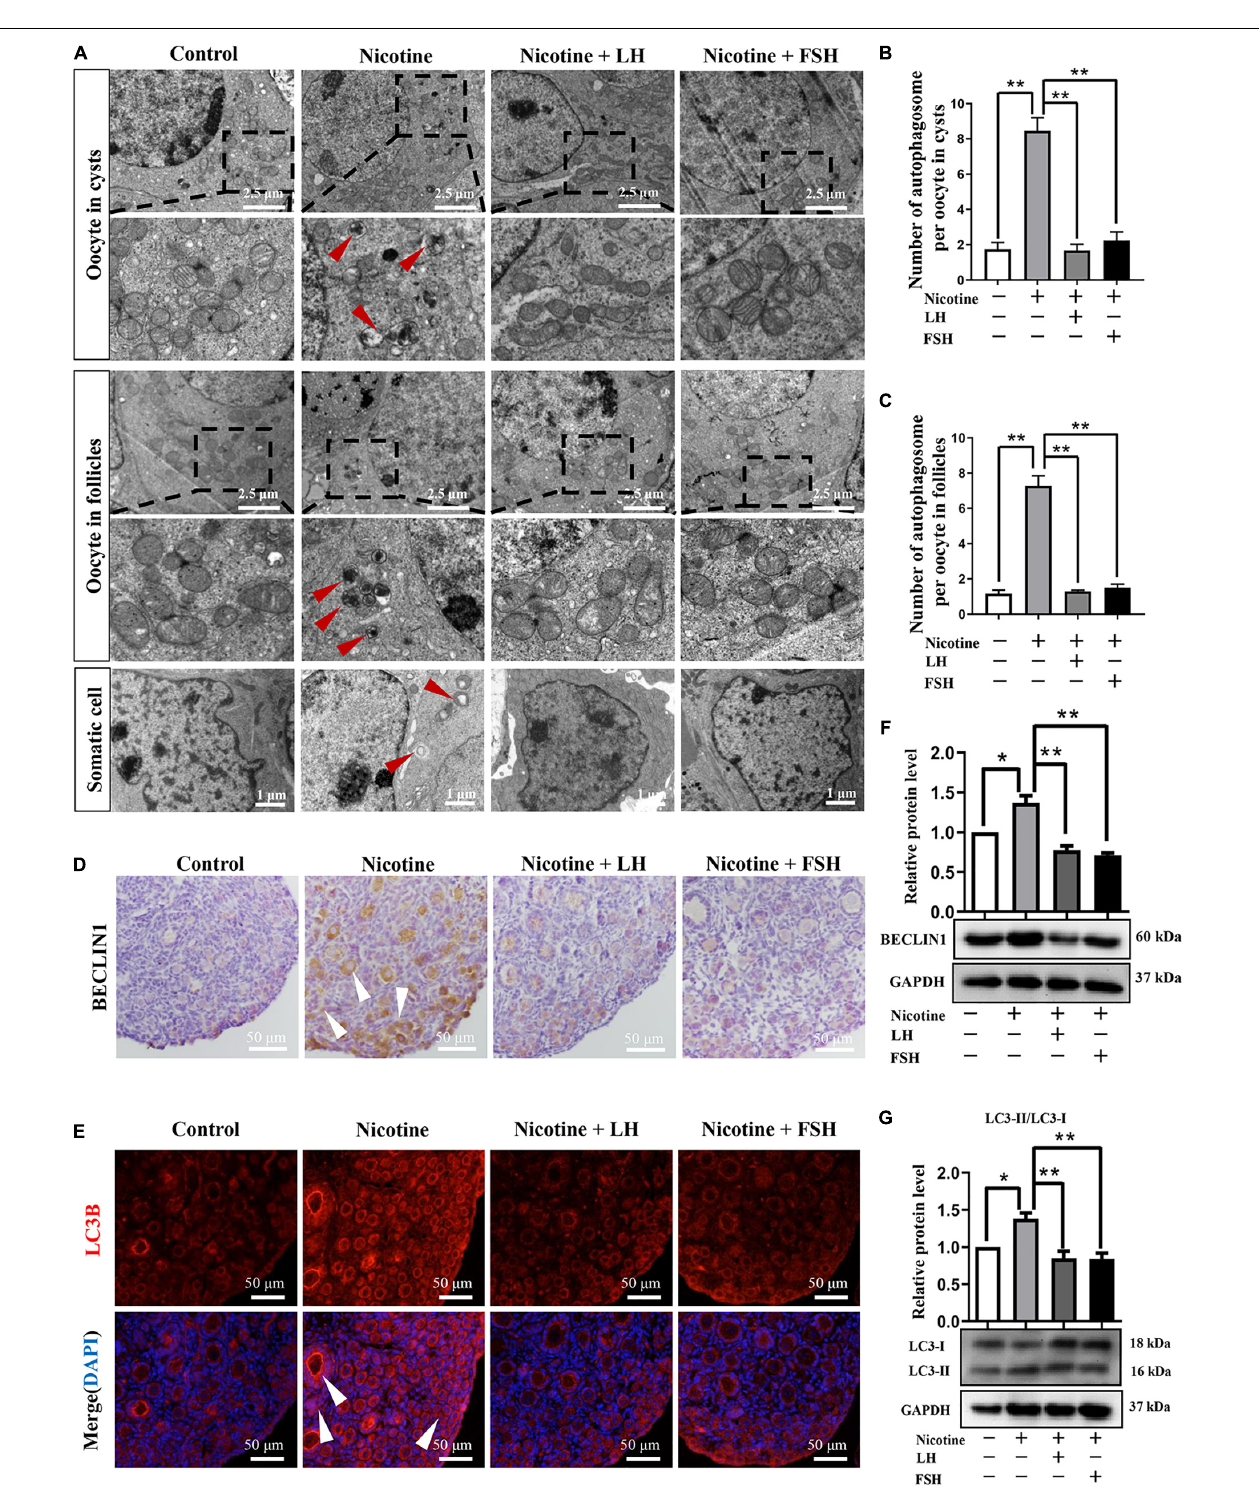
FIGURE 3 | LH and FSH suppressed autophagy in nicotine-exposed ovarian cells. (A) Autophagosomes (black arrow) in the oocyte (cysts or follicles) and somatic cytoplasm in each group’s ovaries with transmission electron microscopy (TEM). (B) The number of autophagosome in one oocyte in cysts of each group’s ovaries (control, n = 90; nicotine, n = 90; nicotine + LH, n = 90; and nicotine + FSH, n = 90, n = total number of oocytes from three replicate experiments). (C) The number